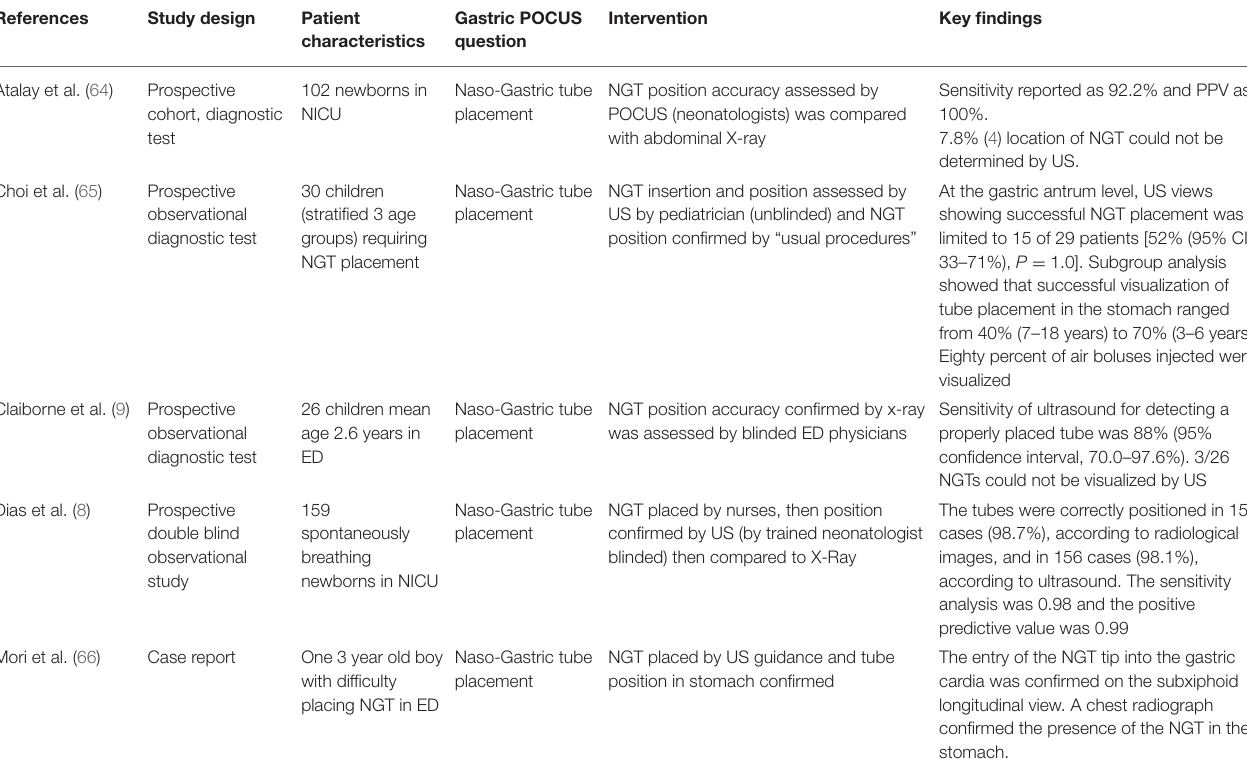
TABLE 3 | Study characteristics and findings: naso-(oro)gastric tube